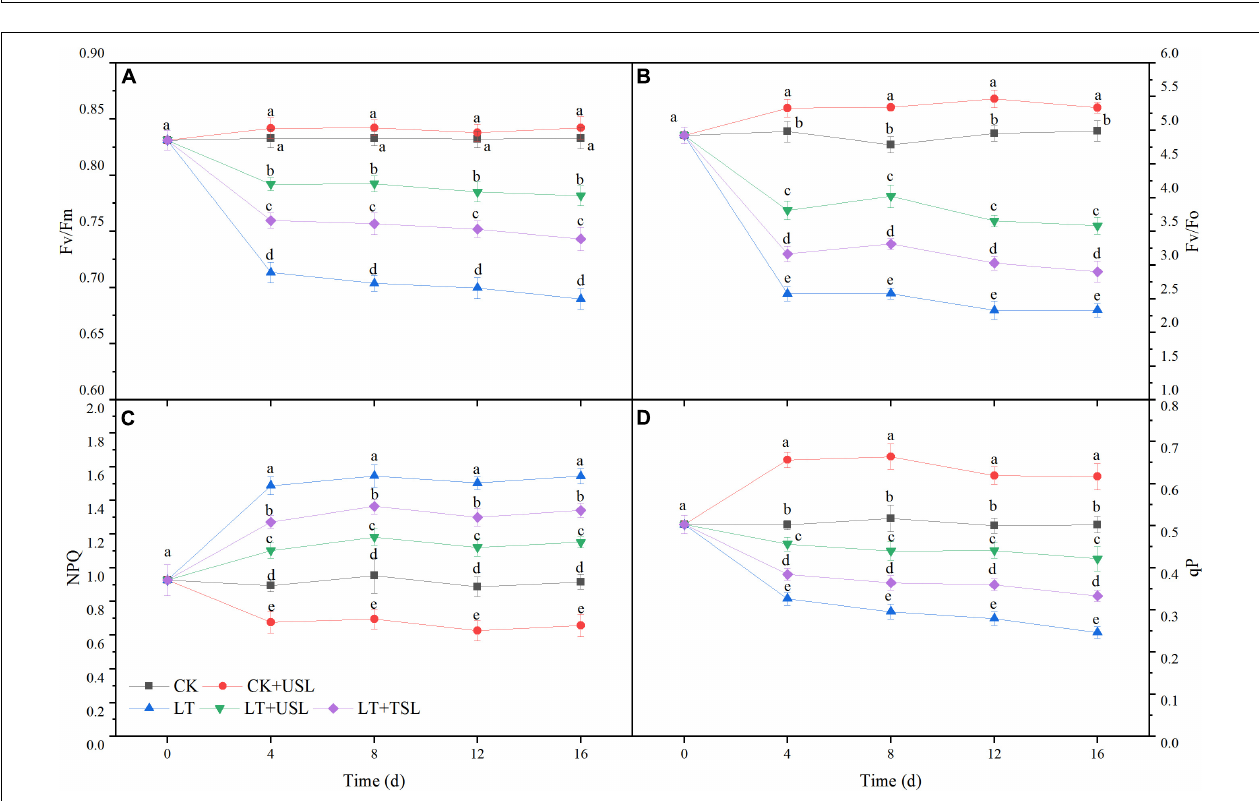
FIGURE 2 | Effects of USL on the Pn-light response curve (A) and Pn-CO 2 response curve (B) of tomato leaves under LT. AQE , apparent quantum efficiency; LSP , light saturation point; LCP , light compensation point; CE , carboxylation efficiency; CSP , CO 2 saturation point; CCP , CO 2 compensation point; Pmax , maximum net photosynthetic rate.